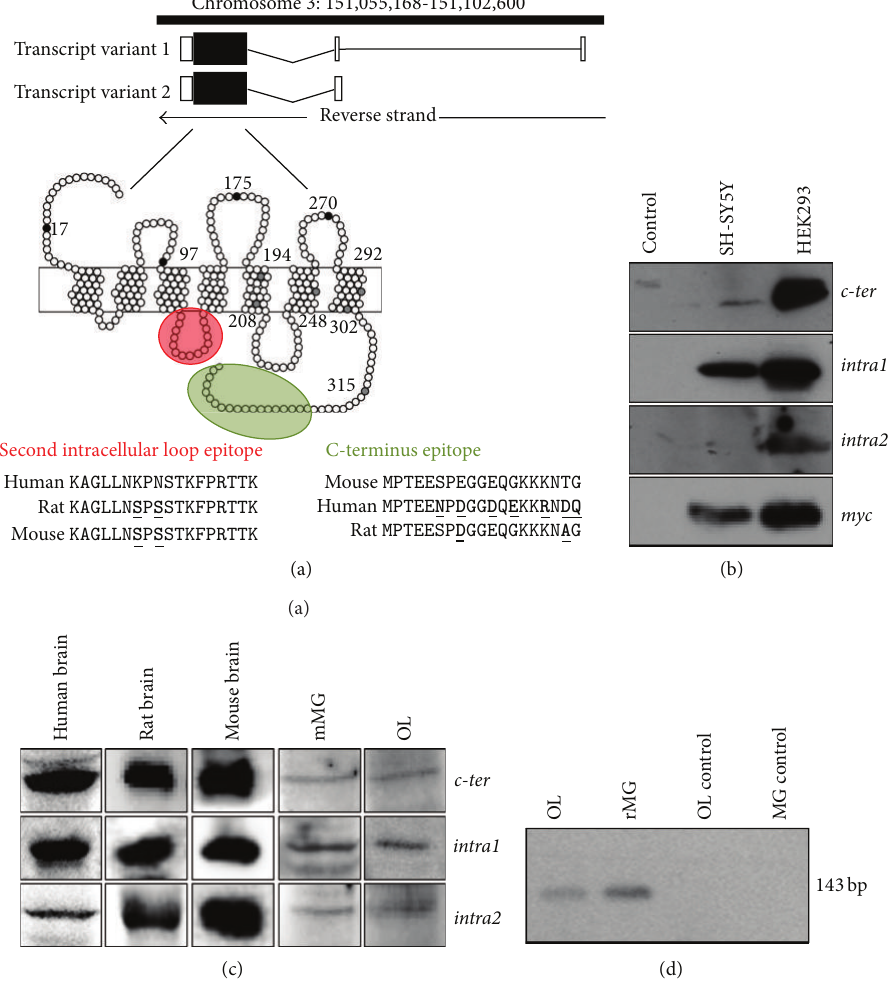
Figure 1: P2Y 12 antibodies validation and RT-PCR analysis. (a) Scheme of human P2RY 12 gene location, transcript variants [29, 30], and protein structure, with amino acid epitopes recognized by the used antibodies (Table 1) and highlighted in color ( intra1 , intra2 , and intra fl , red circle; c-ter , green oval). Species conservation for each epitope was calculated by using BLAT tool of UCSC genome browser [31]. (b) Total protein extracts from SH-SY5Y or HEK293 cells expressing Myc-tagged P2Y 12 receptor were subjected to Western blot analysis with the indicated antibodies. (c) Total protein extracted from human, rat and mouse brain, from primary mouse microglia (mMG) and rat oligodendrocyte (OL) cultures were subjected to Western blot analysis with the indicated antibodies. For intra2 antibodies, lots AN01/02/04/0502/0602 were used. (d) RT-PCR using primers specific for P2Y 12 mRNA was performed on total RNA from rat microglia (rMG) and OL. Control lanes show RT-PCR performed without reverse transcriptase